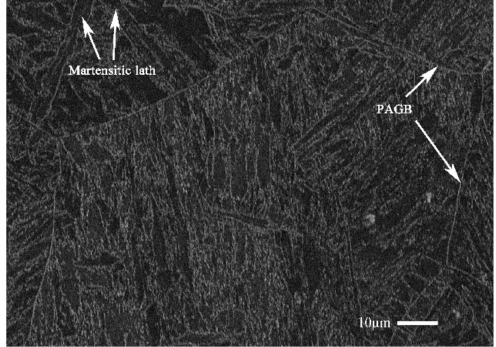
Figure 2. The microstructure of 9%Cr turbine